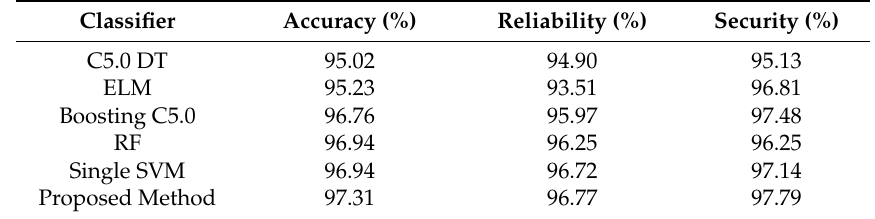
Table 2. Performance of different classifiers. DT: decision tree; ELM: extreme learning machine; RF: random forest.